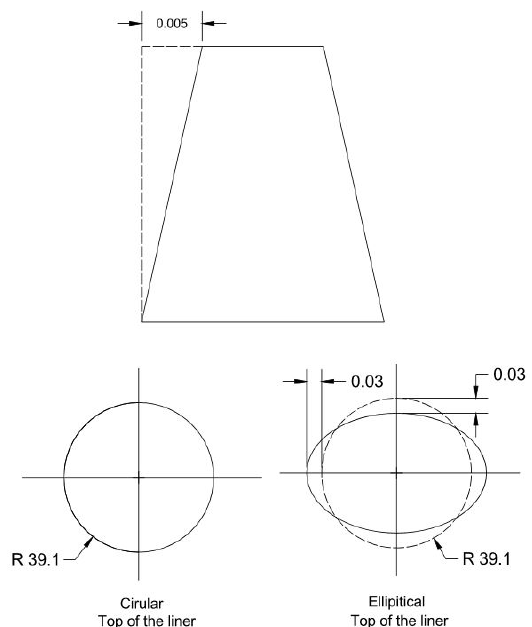
Figure 3. Dimensions and cross sections for conical liners (Dimensions in millimeter).